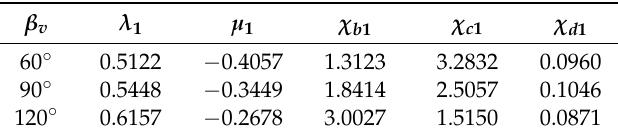
Figure 4. The experimental setup of micro-crack induced severing. Table 3. The auxiliary parameters.